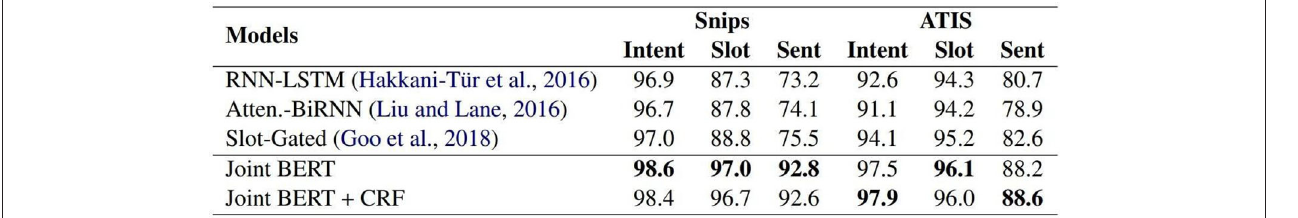
FIGURE 3 | F1 Score on both datasets.